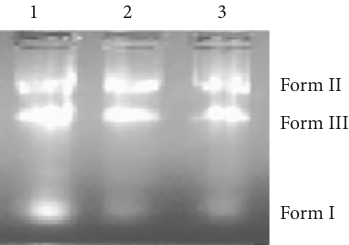
Figure 10: Cleavage pattern of pBR322 DNA by complexes 1 and 2 . Lane 1, control; lane 2, complex 1 + DNA; lane 3, complex 2 + DNA.